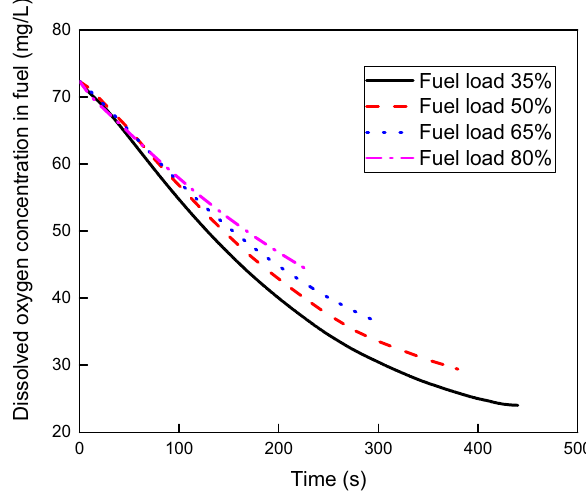
Figure 12. Dissolved oxygen concentration versus scrubbing time at various fuel loads.